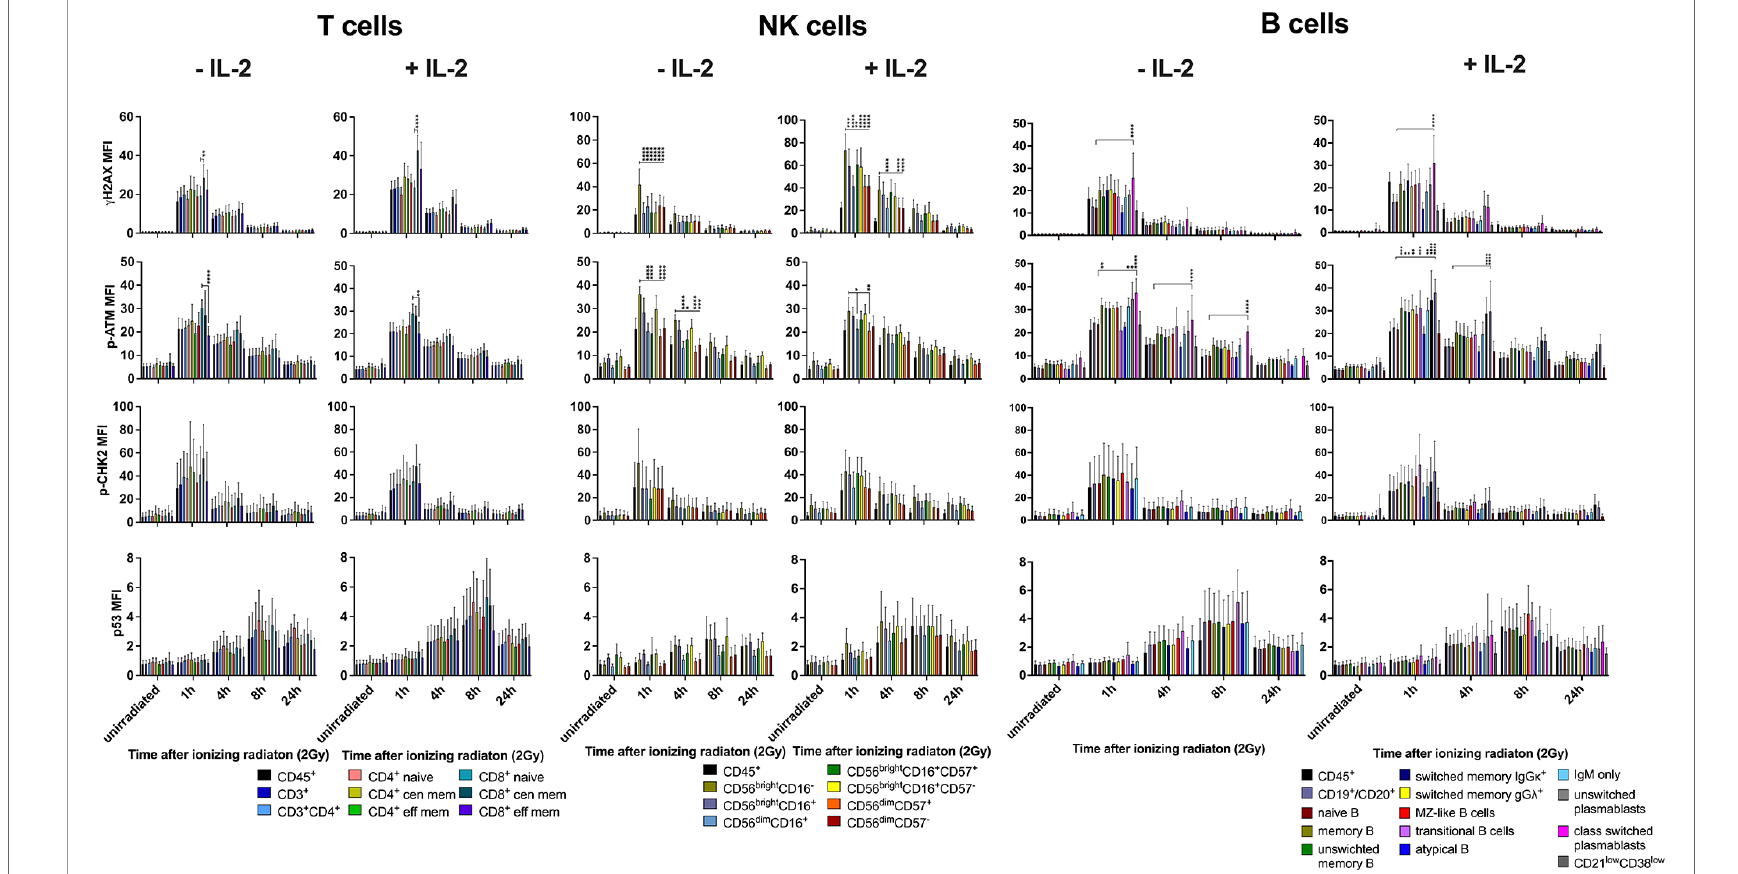
FIGURE 5 | Differential DDR in lymphocyte subsets is independent from IL-2 stimulation. PBMCs of 6 healthy donors were cultured in RPMI media without and in presence of 100U/ml human IL-2 for 48h. Cells were irradiated with 2Gy and fi xed at indicated time points. Mean fl uorescence intensities (MFI) of DDR markers g H2AX, p-ATM, p-CHK2 and p53 are shown in T, NK and B lymphocyte subsets of unirradiated lymphocytes and 1h, 4h, 8h, 24h following IR with 2Gy (*p ≤ 0.05, **p ≤ 0.01, ***p ≤ 0.001, ****p ≤